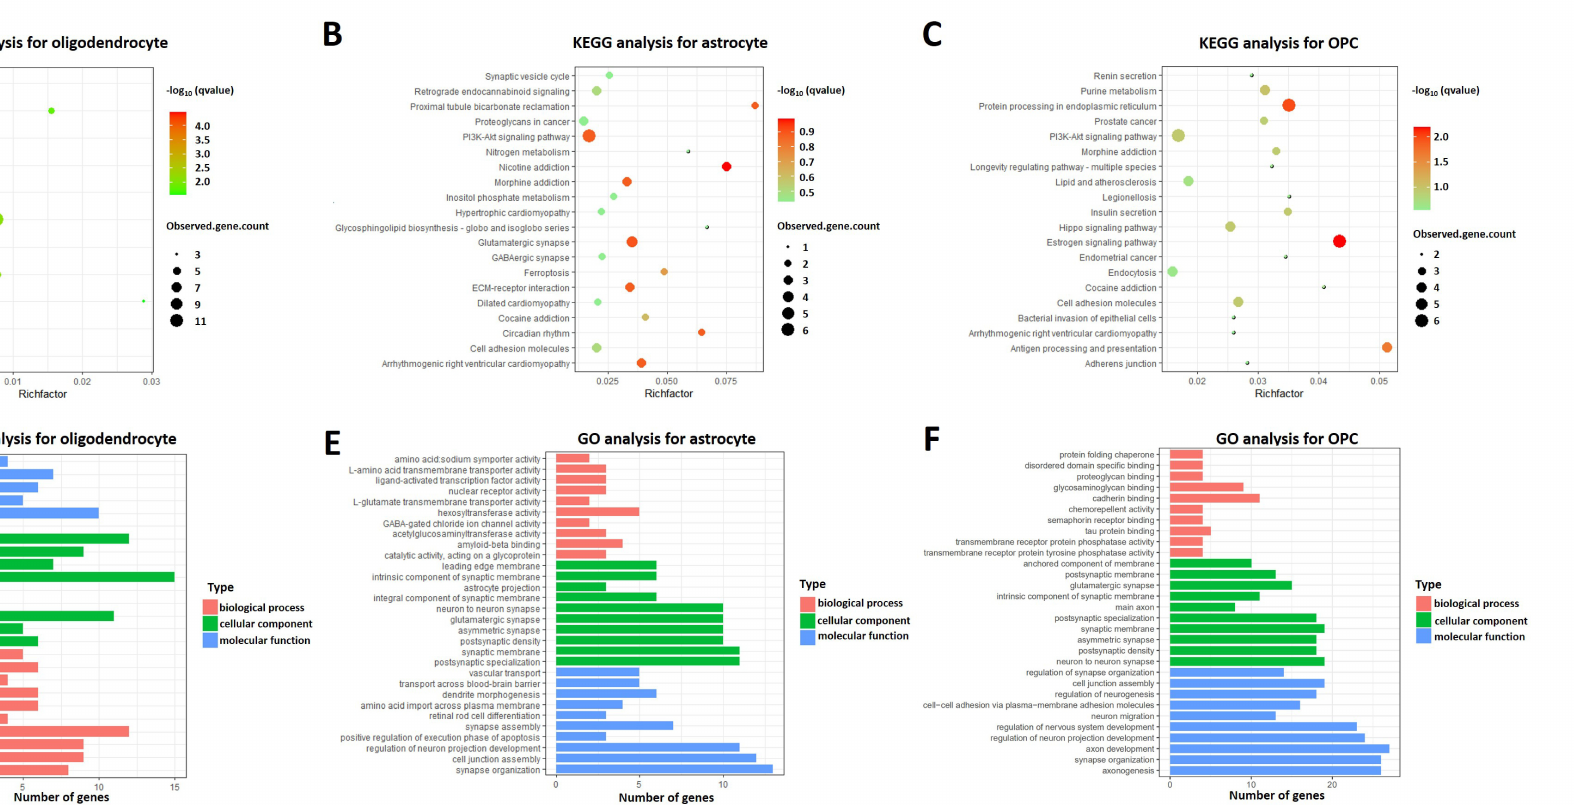
Figure 5. Enrichment analysis of DEGs in oligodendrocytes, astrocytes, and OPCs. ( A ) KEGG analysis of DEGs in oligodendrocytes. ( B ) KEGG analysis of DEGs in astrocytes. ( C ) KEGG analysis of DEGs in OPCs. ( D ) GO analysis of DEGs in oligodendrocytes. ( E ) GO analysis of DEGs in astrocytes. ( F ) GO analysis of DEGs in OPCs. GO: Gene Ontology. KEGG: Kyoto Encyclopedia of Genes and